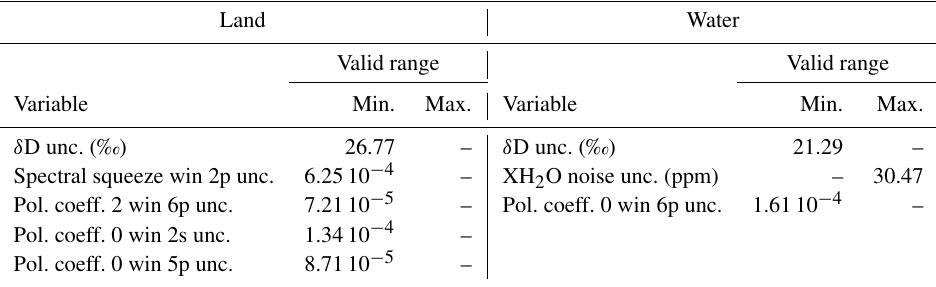
Table A4. XH 2 O filter variables and limits for GOSAT. “–” means that no limit is applied. The variables are ordered by their relevance, i.e. by the number of data filtered out.